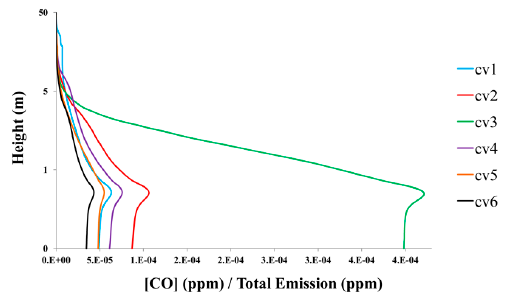
Figure 8. Double averaged profiles of CO concentration normalized with the total emission for the six validation